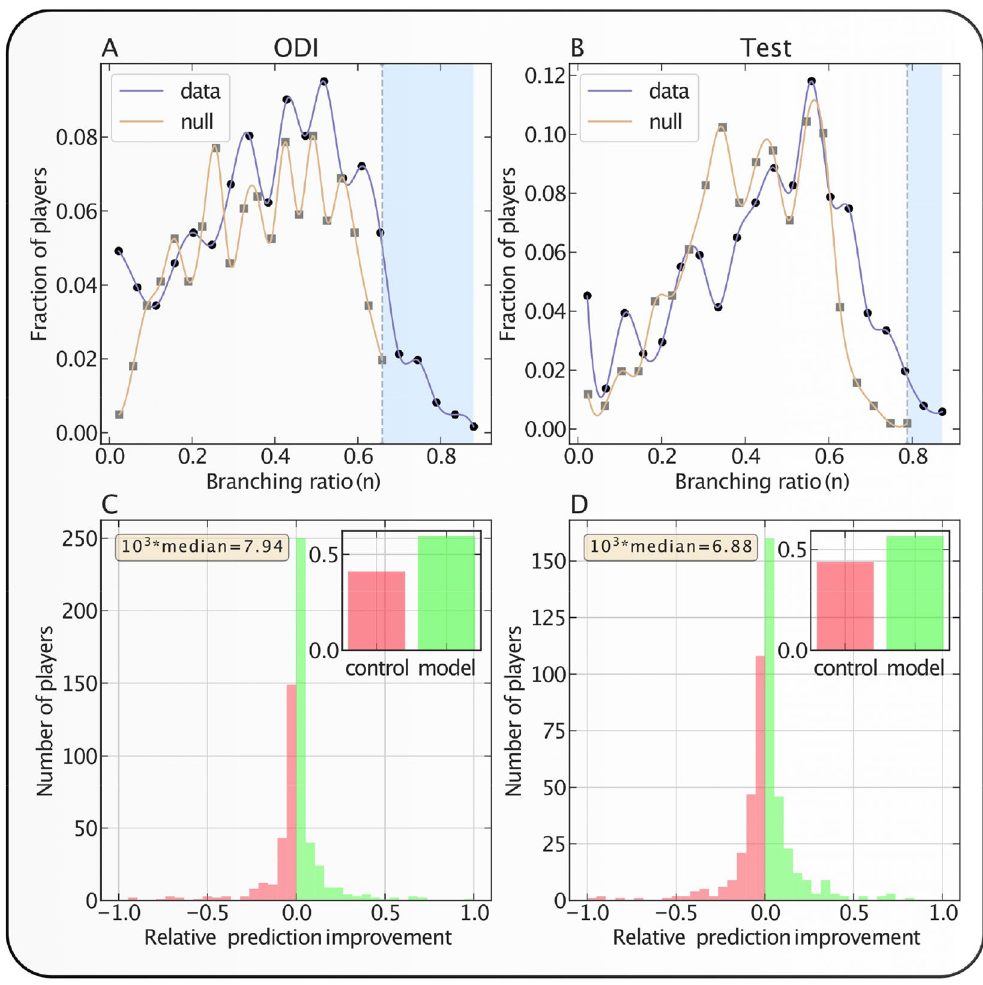
Figure 4. Analysis of clustering in the time series of performance time with the self-excited point process model. ( A , B ) represent the distribution of branching ratios over the set of players and of the branching ratios obtained from synthetic shuffled careers. ( A ) represents the distribution for ODI cricket and ( B ) is for Test cricket. Shaded regions in the plot represent the domain of branching ratios obtained from the real data that cannot be explained by the null models. ( C , D ) show the distribution of δ( L model j , L control j ) (see Eq. (7)). ( C ) represents the distribution for ODI cricket, and ( D ) is for the Test format. The fraction of the times models achieve a better log-likelihood score compared to the controls is colored green, otherwise the color is red. The insets show the fraction of controls and models outperforming their counterparts. In ODI games, the fraction of times models perform better than the controls is: 0.62; for Test cricket, this fraction is